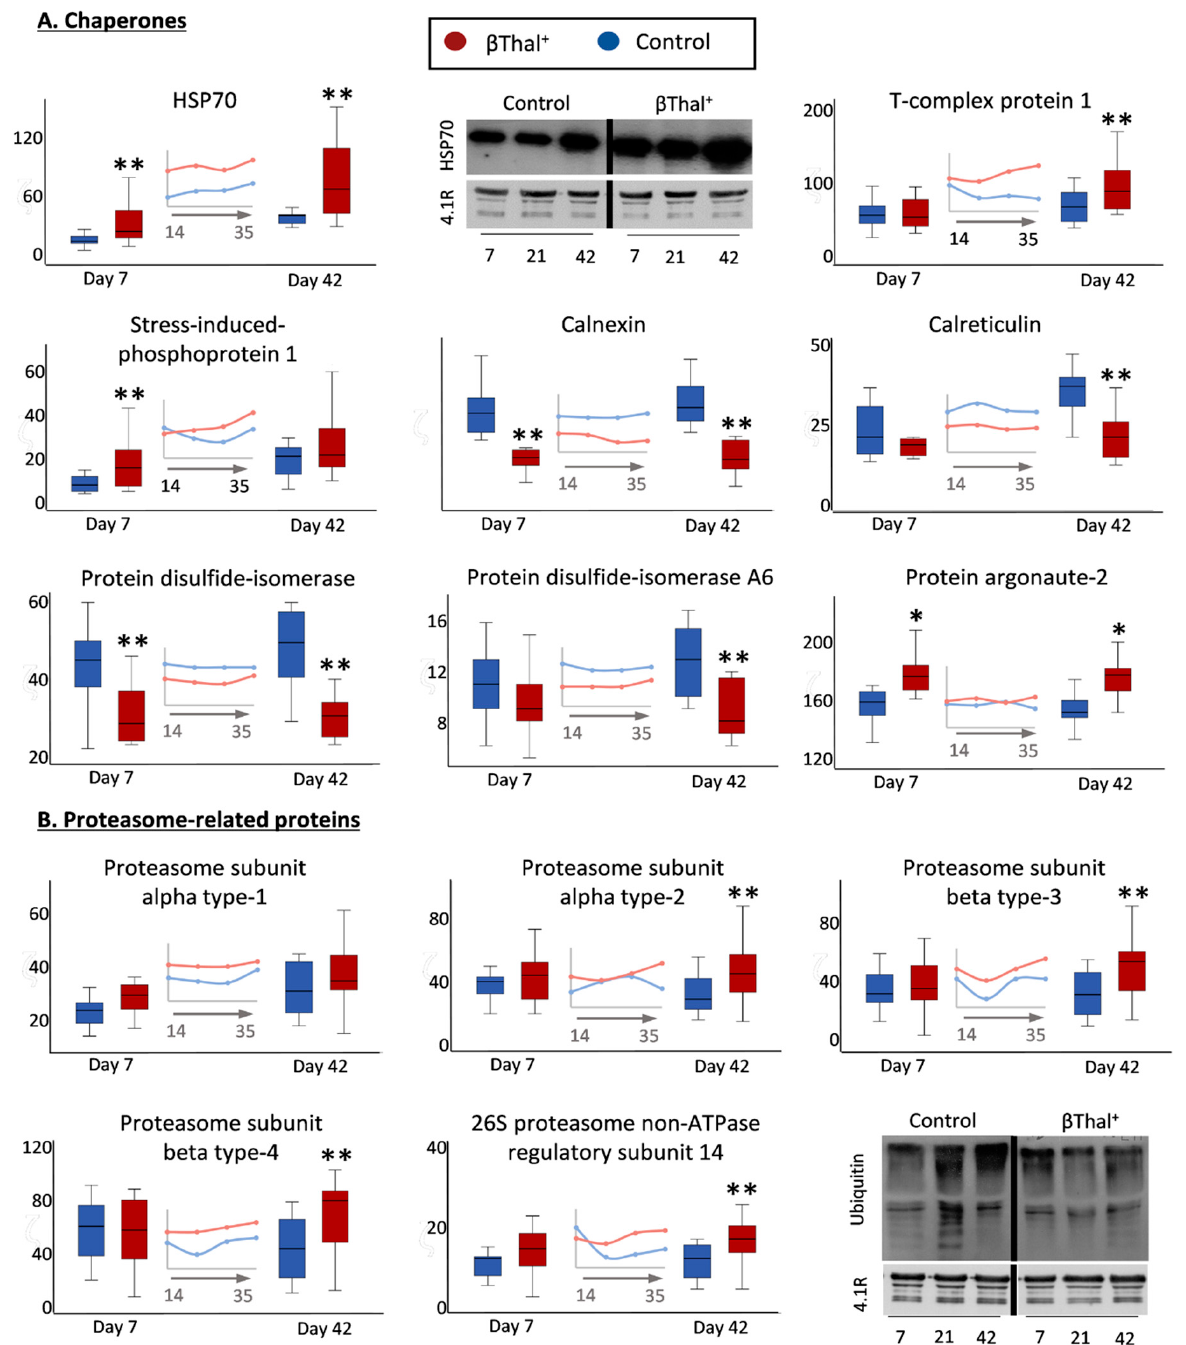
Figure 7. Proteomics analysis of stored RBC membranes: “repair or destroy” group of proteins. Variation in the membrane levels of selected chaperones ( A ) and of 20S/26S proteasome subunits ( B ) in β Thal + and control RBCs throughout storage. Inserts: pooled analysis of membrane samples at weekly intervals. (*) p < 0.05 β Thal + vs. controls; (**) p < 0.05 and fold > 1.25 β Thal + vs. controls. Representative immunoblots showing variation in the levels of heat shock protein-70 (HSP70) and of ubiquitinylated proteins at early, middle, and late storage are also shown ( n = 7 per group). Protein 4.1R was used as internal loading control.